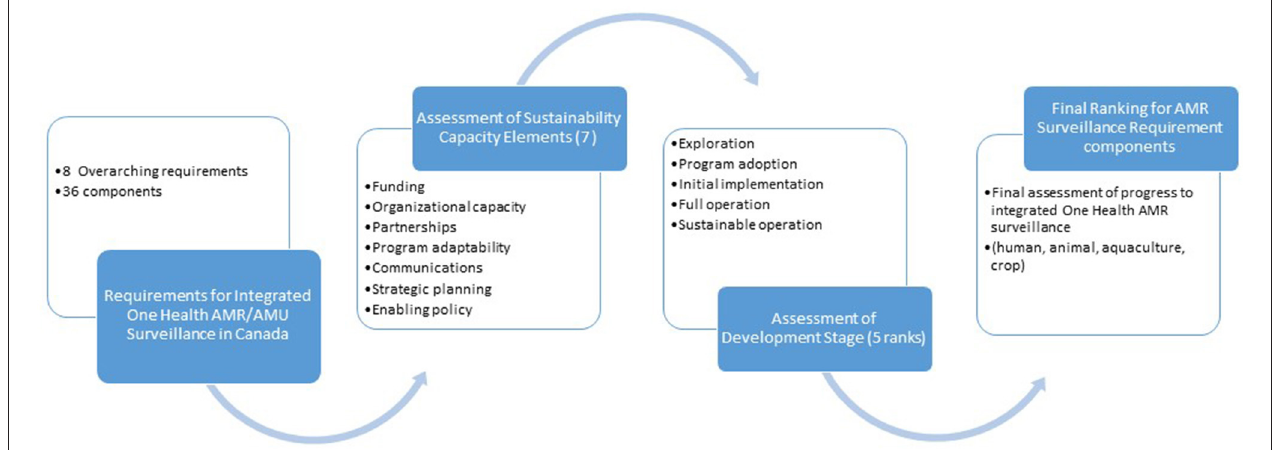
FIGURE 1 | Step-wise process used to develop and use the OHE-AMURS novel